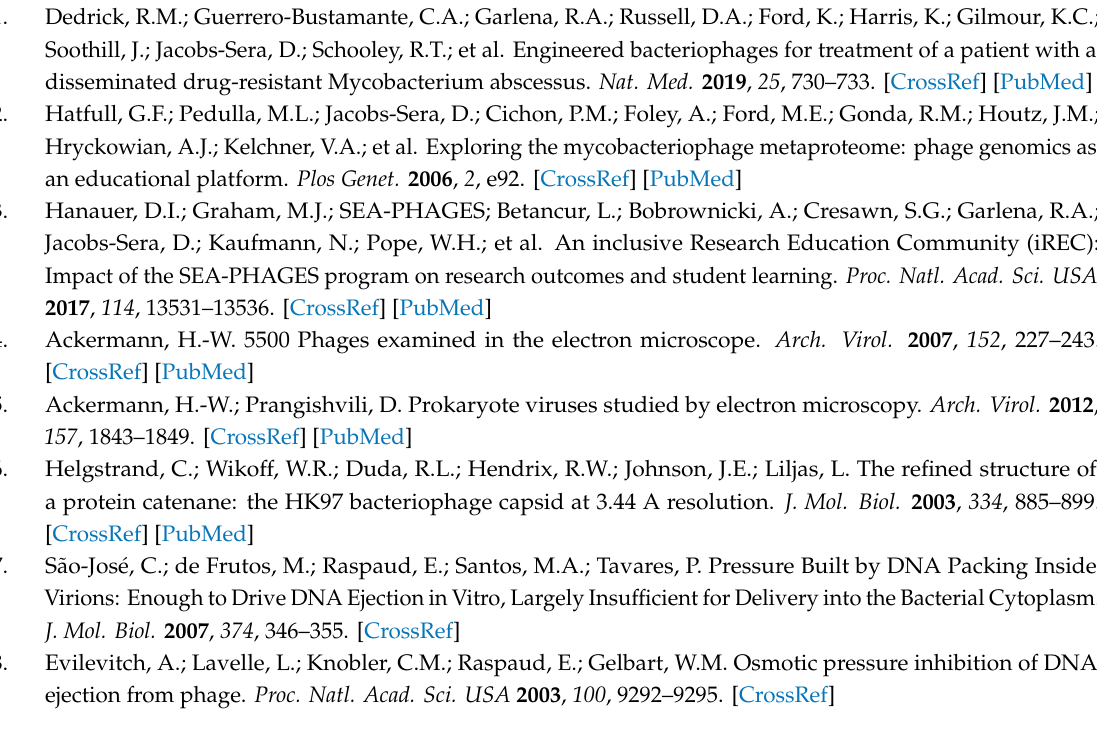
Figure S1: HHPRED prediction of Rosebush gp17. Figure S2: 2D classes selected from multiplexed Rosebush and Patience cryo-EM grid. Figure S3. I-TASSER predicted model of Patience gp29 fitted into decoration protein density. Figure S4: Multiple sequence alignment of bacteriophage proteins that are related (in the same pham) to Myrna minor coat protein 98. Figure S5: Multiple sequence alignment of bacteriophage proteins that are related (in the same pham) to Rosebush gp17. Table S1: Mass spectrometry data analysis of band 1 from SDS-PAGE of Rosebush capsid. Table S2: Mass spectrometry data analysis of band 2 from SDS-PAGE of Rosebush capsid. Table S3: Mass spectrometry data analysis of band 3 from SDS-PAGE of Rosebush capsid. Table S4: Mass spectrometry data analysis of band 4 from SDS-PAGE of Rosebush